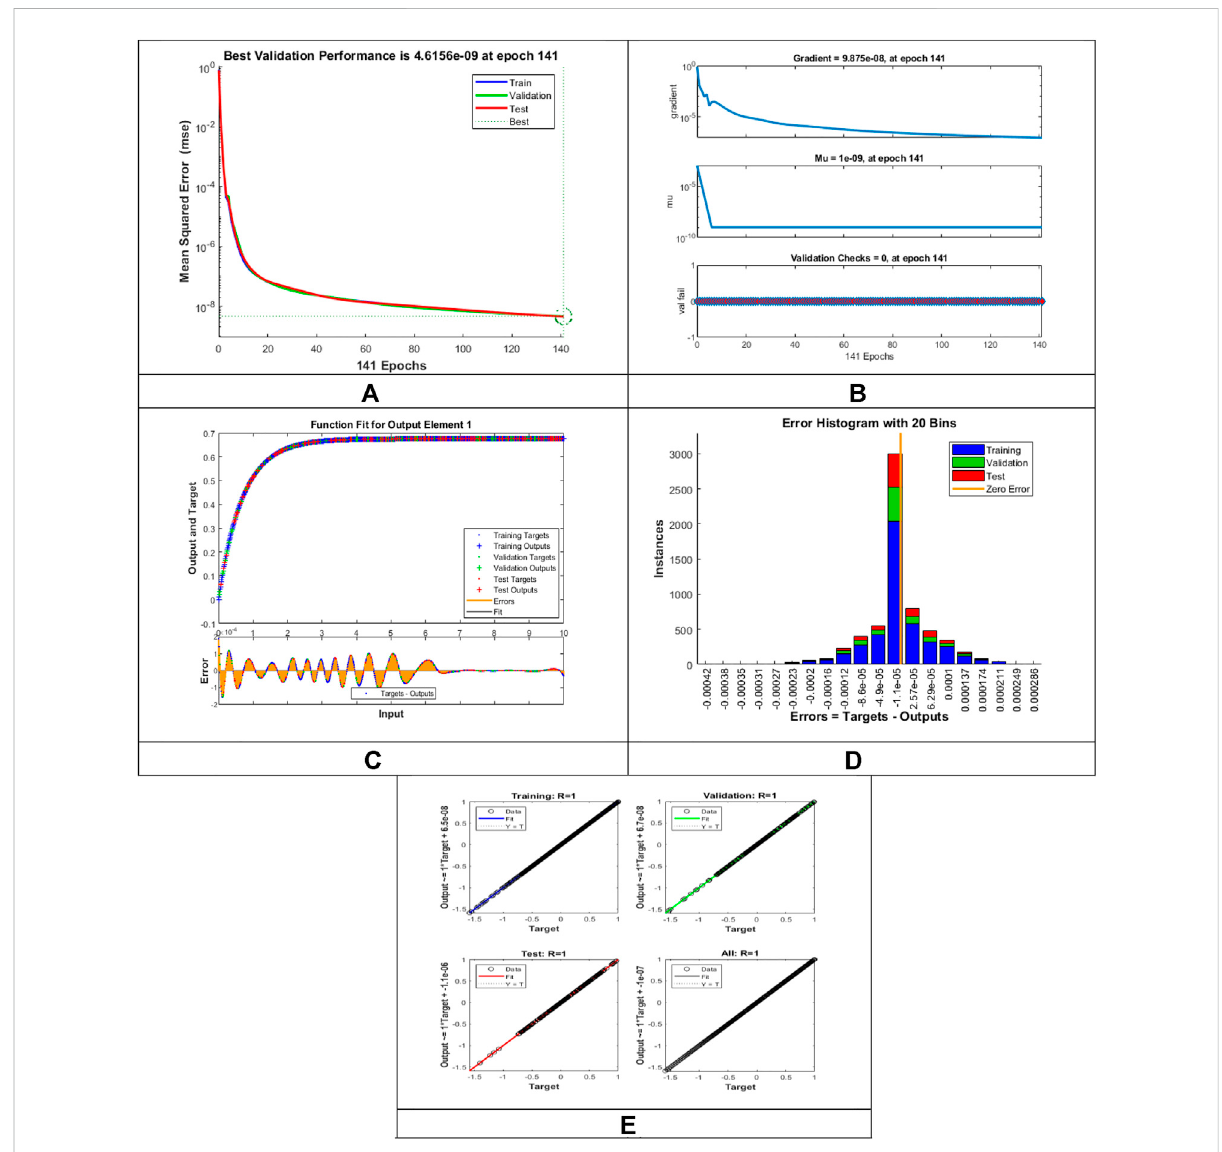
FIGURE 7 Pictorial illustration fortheLMLA-BPNN baseonvariantsof Rvs θ ( η ) forMHD-WNF-HGA. (A) M-S-E demonstration, (B) transition stateanalysis, (C) curve fi tting, (D) error histogram, and (E) regression